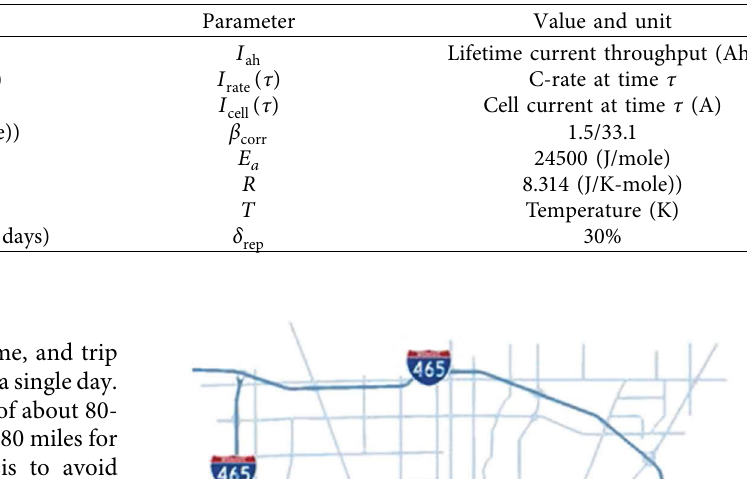
Table 4: Battery degradation parameter values and units.